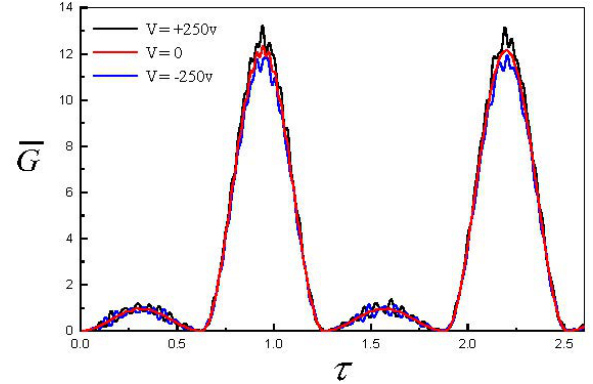
Figure 5. Effect of voltage on energy release rate of delaminated piezoelectric shell